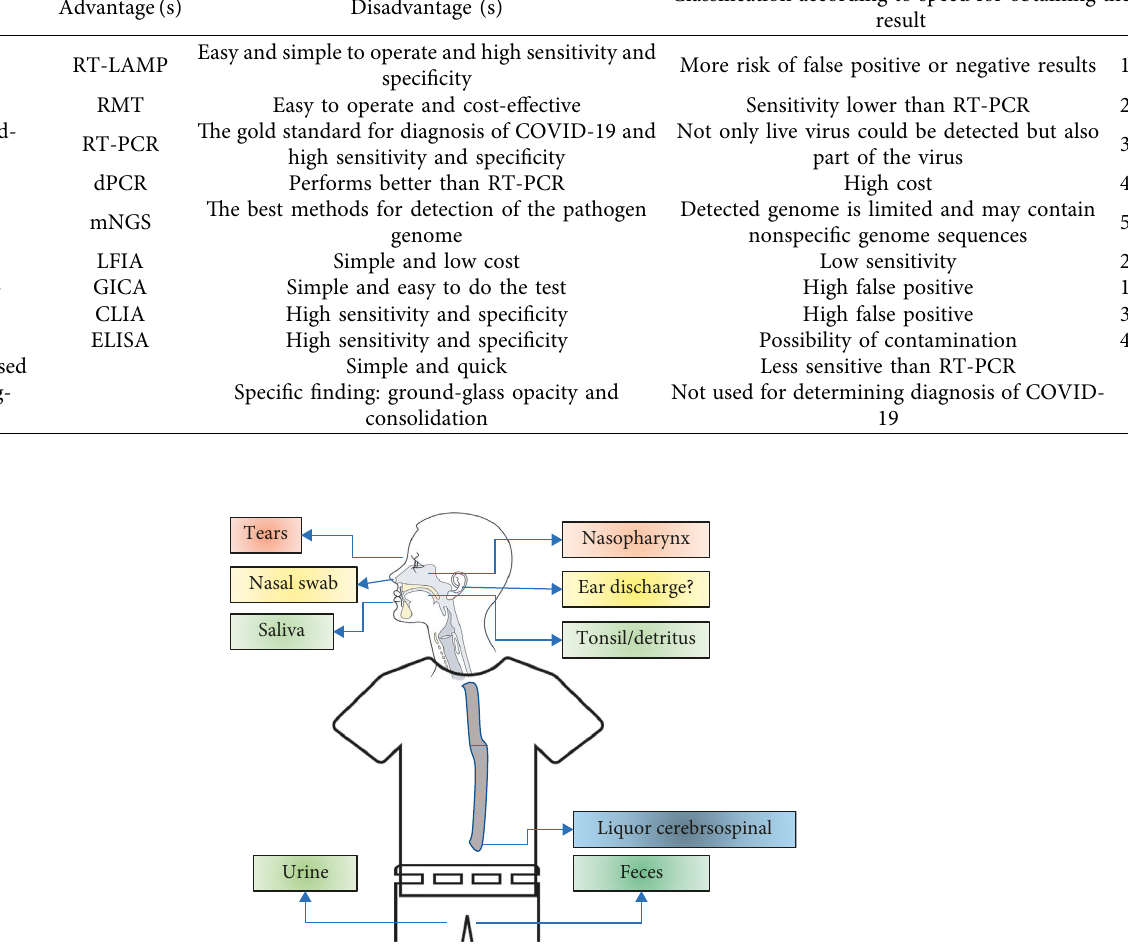
Figure 1: The sample collection site for the diagnosis of COVID-19.